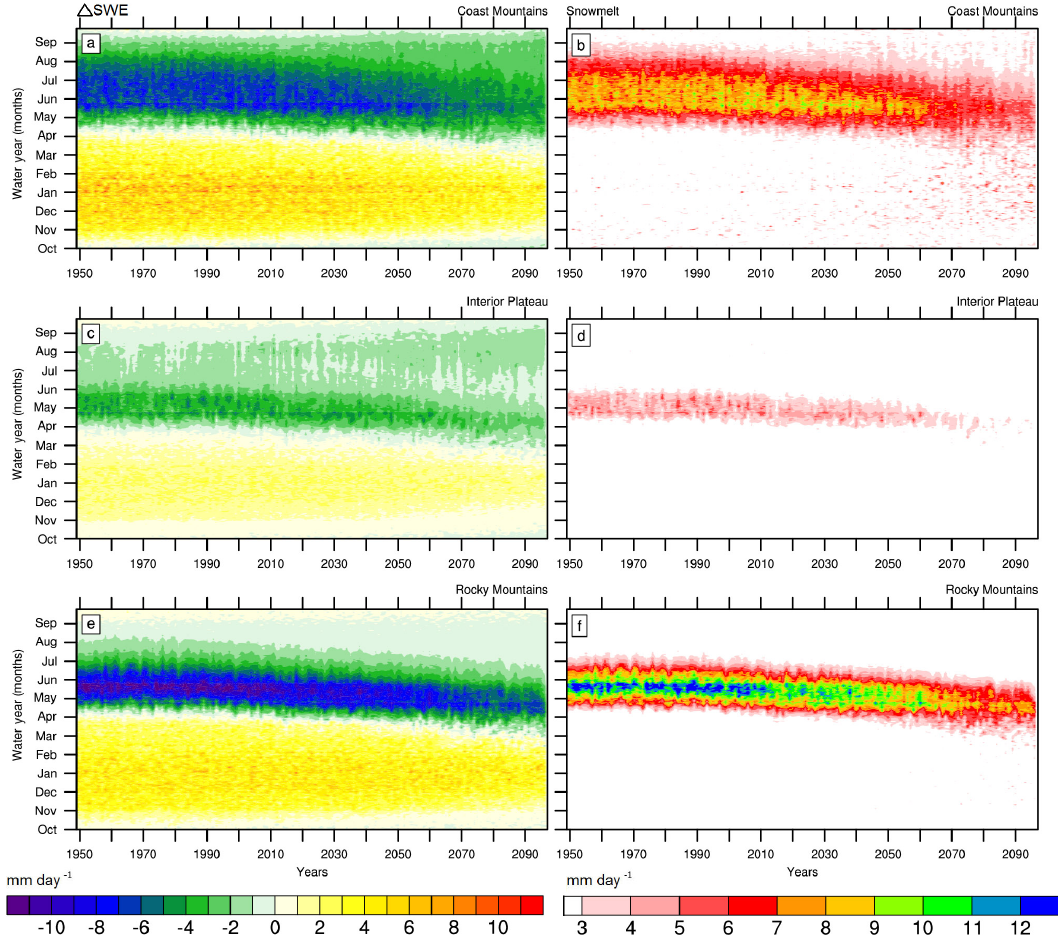
Figure 5. CMIP5-VIC-simulated MME mean (cid:49) SWE (daily SWE rate) (a, c, e) and snowmelt (b, d, f) for the Coast Mountains (a, b) , Interior Plateau (c, d) and Rocky Mountains (e, f) . In (a) , (c) and (e) , values greater than 0 represent snow accumulation, while those below 0 indicate snow ablation. Units are mmday − 1